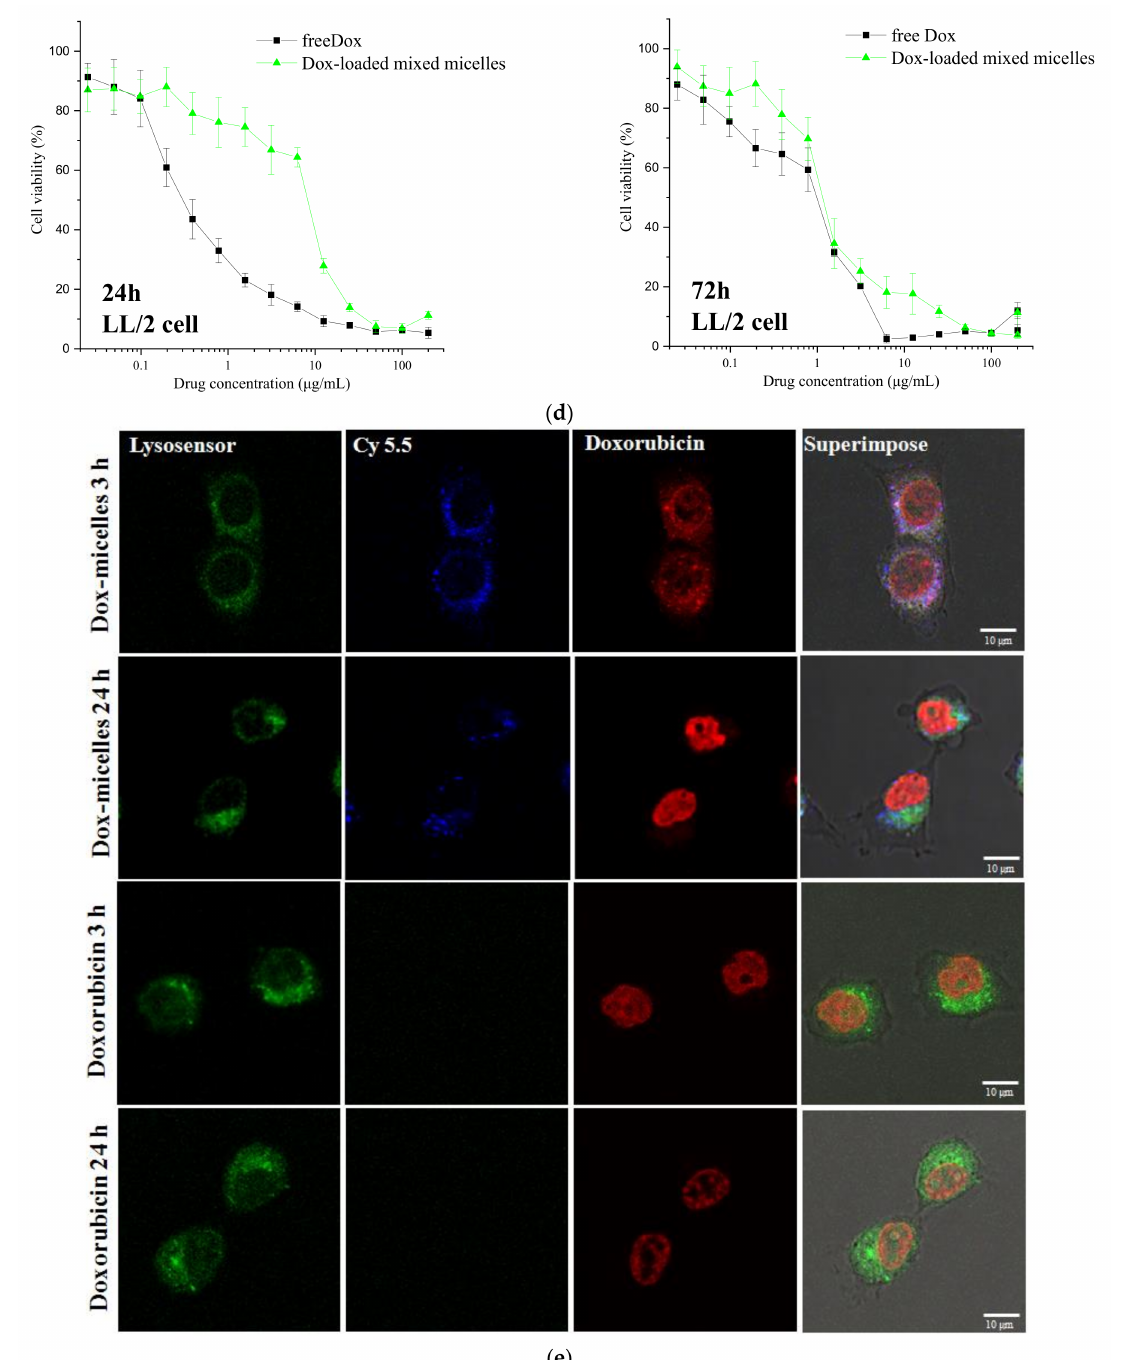
Figure 3. In vitro cytotoxic assessment and internalization observation. The cytotoxicity of the blank L4 polymeric mixed micelles was assessed with human ovary cancer cell line ES2 and mouse Lewis lung cancer cell line LL/2 after ( a ) 24 h and ( b ) 72 h co-incubation. The in vitro toxicity of the free Dox and Dox-mixed micelles toward the ( c ) human ovary cancer cell line ES2 and ( d ) mouse Lewis lung cancer cell line LL/2 were also estimated for 24 and 72 h. The cytotoxicity was determined using an MTT assay. The cell viability is presented as mean ± SD ( n = 3). ( e ) The free Dox and Dox-mixed micelles, which were labeled in advance with the fluorescent Cy 5.5, were observed using a CLSM system. The LL/2 cells were incubated with Cy-5.5-labeled Dox-loaded micelles and doxorubicin at 37 ◦ C for 3 and 24 h; afterward, their endo-lysosomes were also stained with LysoSensor for observation. The fluorescence of the Cy 5.5, Dox, and LysoSensor were independently detected with the appropriate excitation and emission wavelengths and are presented in blue, red, and green,